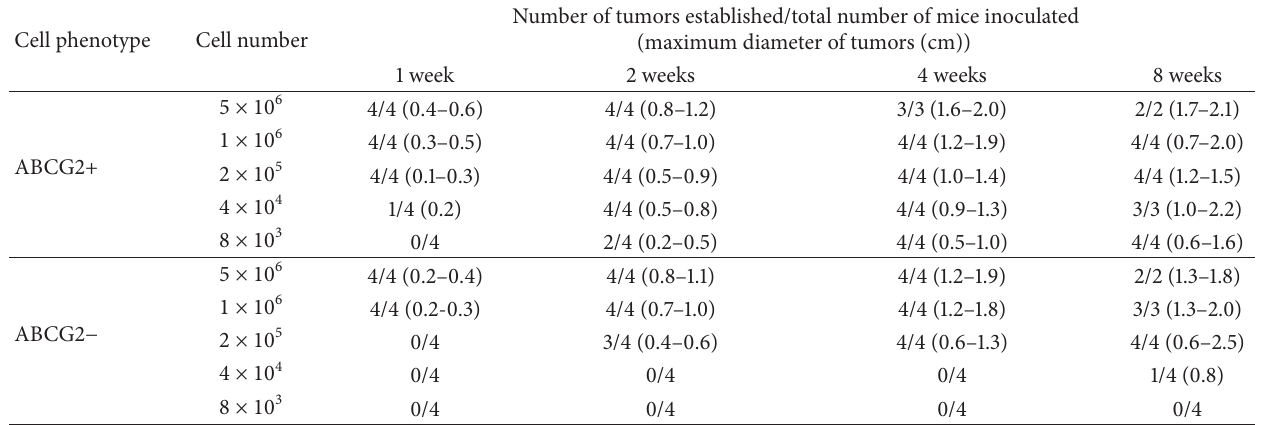
Table 2: Difference of tumorigenic ability between ABCG2+ and ABCG2 −